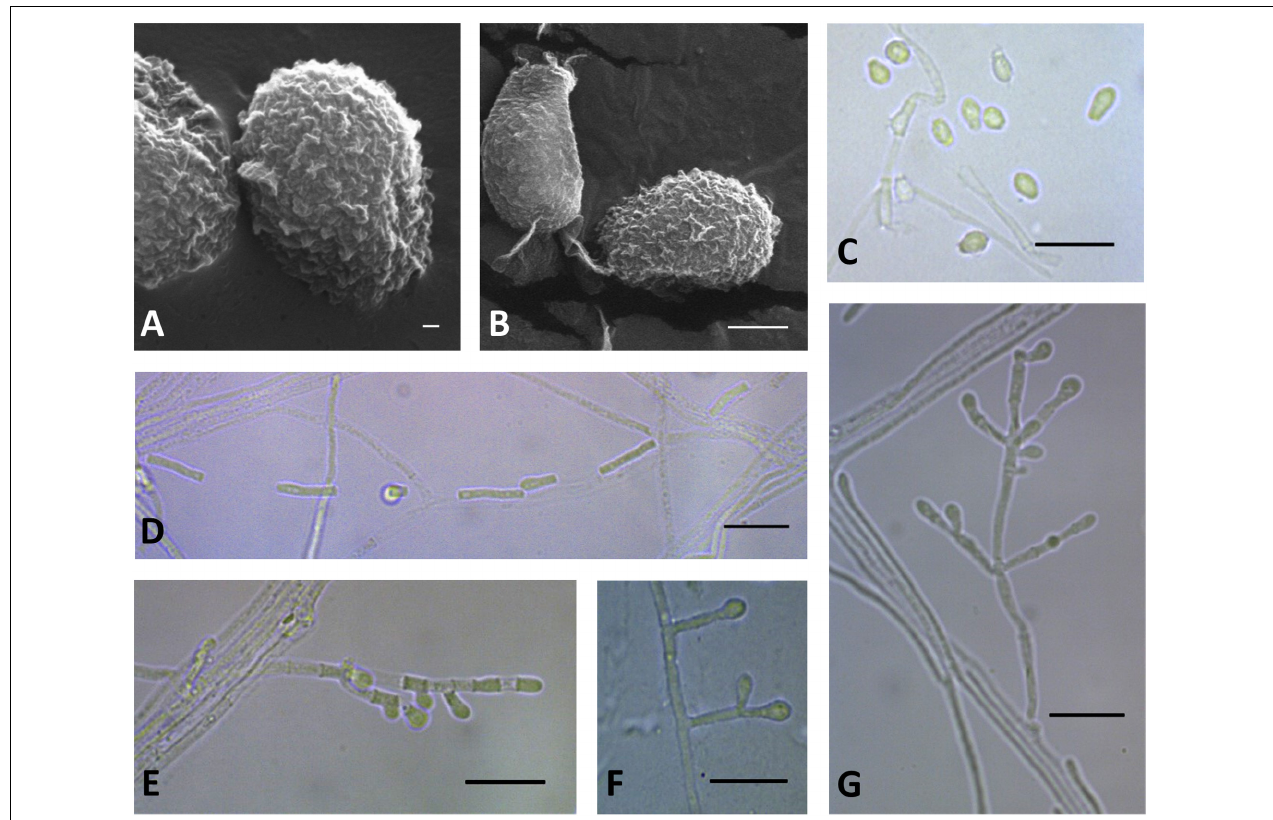
FIGURE 9 | Microscopic analysis of Pseudogymnoascus lanuginosus sp. nov. Conidia (A,B,C) ; Chain of arthroconidia (D) ; Fertile hyphae bearing arthroconidia and aleurioconidia, sessile, or stalked (E) ; Stalked aleurioconidia (F) ; Conidiophore (G) . In panels (A,B) , the structures were observed using transmission electron microscopy, while in panels (C–G) , light microscopy was used. Scale bars = 200 nm (A) , 1 µ m (B) , and 10 µ m (C–G) .